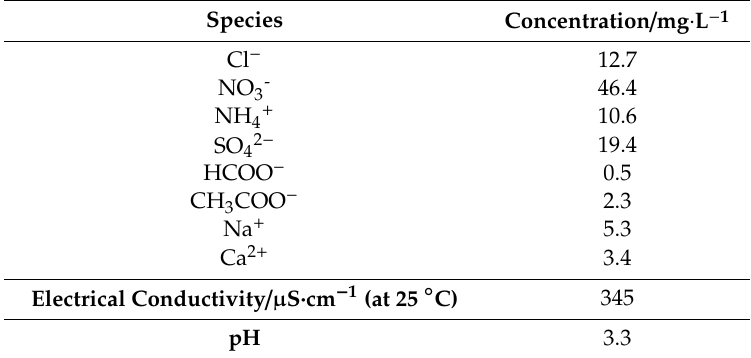
Table 2. Characteristics and composition of the tenfold concentrated synthetic acid rain (AR ×